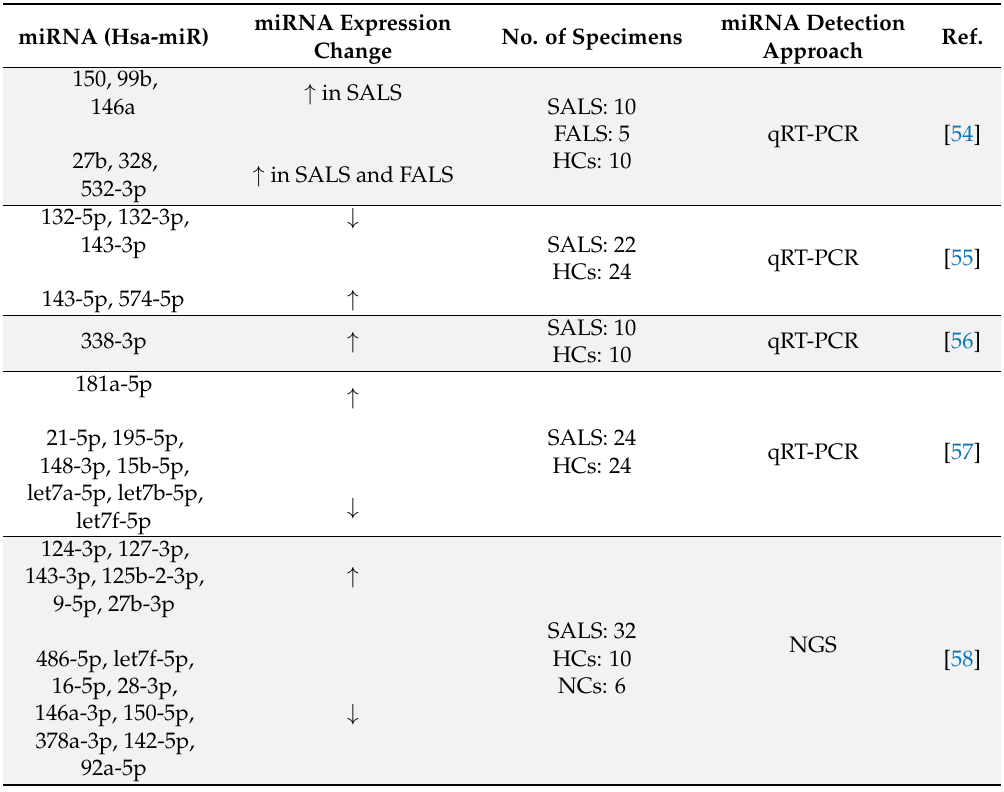
Table 1. Deregulated microRNAs (miRNAs) in cerebrospinal fluid (CSF) of amyotrophic lateral sclerosis (ALS) patients compared to healthy